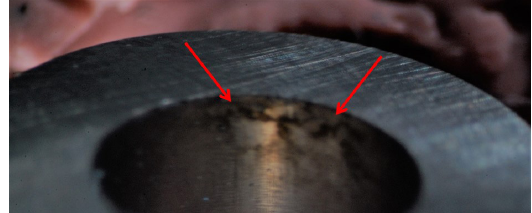
Figure 10. CPT tests for UNS N10276 samples. Crevice corrosion occurrence in all tests, represented in dotted lines.